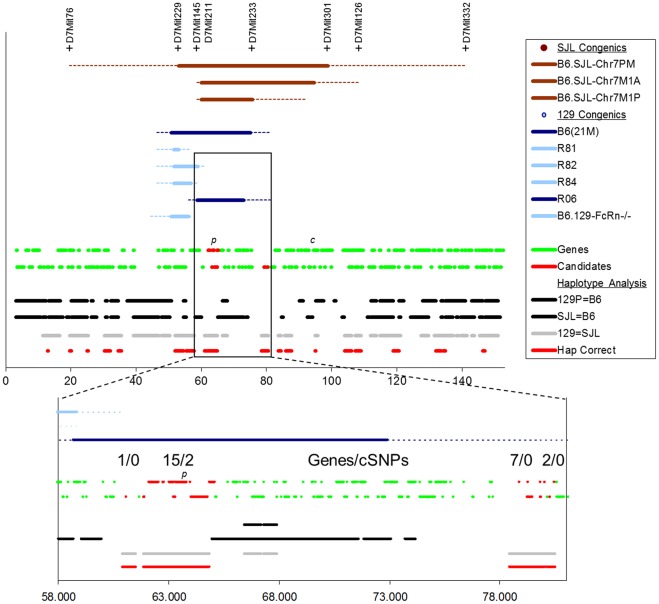
Mapping the region responsible for AngFq5.Top: Location of the congenic regions for the congenic strains used is plotted, along with boundary-defining markers for SJL congenics (brown). Blue indicates 129 congenics, with dark blue indicating those congenics that demonstrate a statistically significant difference in angiogenic response. Genes are indicated next by which DNA strand they are coded by. Finally regions of shared haplotype are indicated colored by whether the parental strains have disparate (black) or shared (grey) alleles at AngFq5. Below: Magnification of the region of interest defined by the R82 and R06 congenics. The number of genes, and genes bearing amino-acid altering polymorphisms (cSNPs), is indicated as are the locations of the pink-eyed dilution gene (p) and the tyrosinase gene (c). Scale is in Mbp on build 37.1 of mouse Chromosome 7.